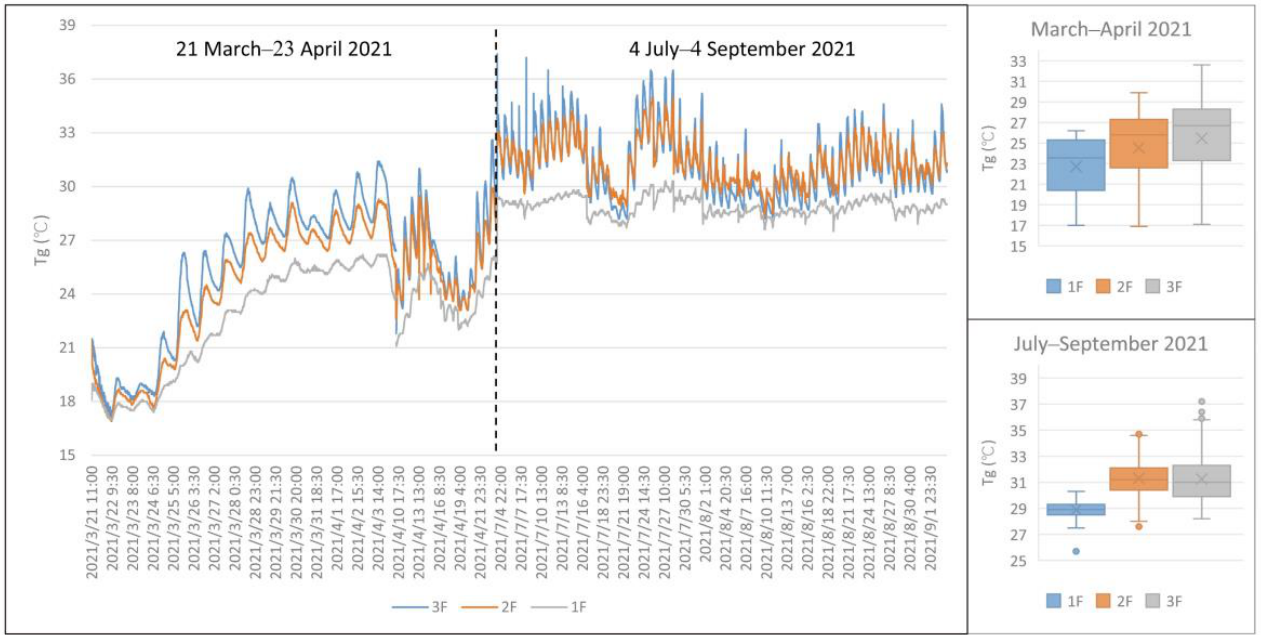
Figure 15. Average Ta and RH measurement data (January – September 2021), drawn by the stu- dents.